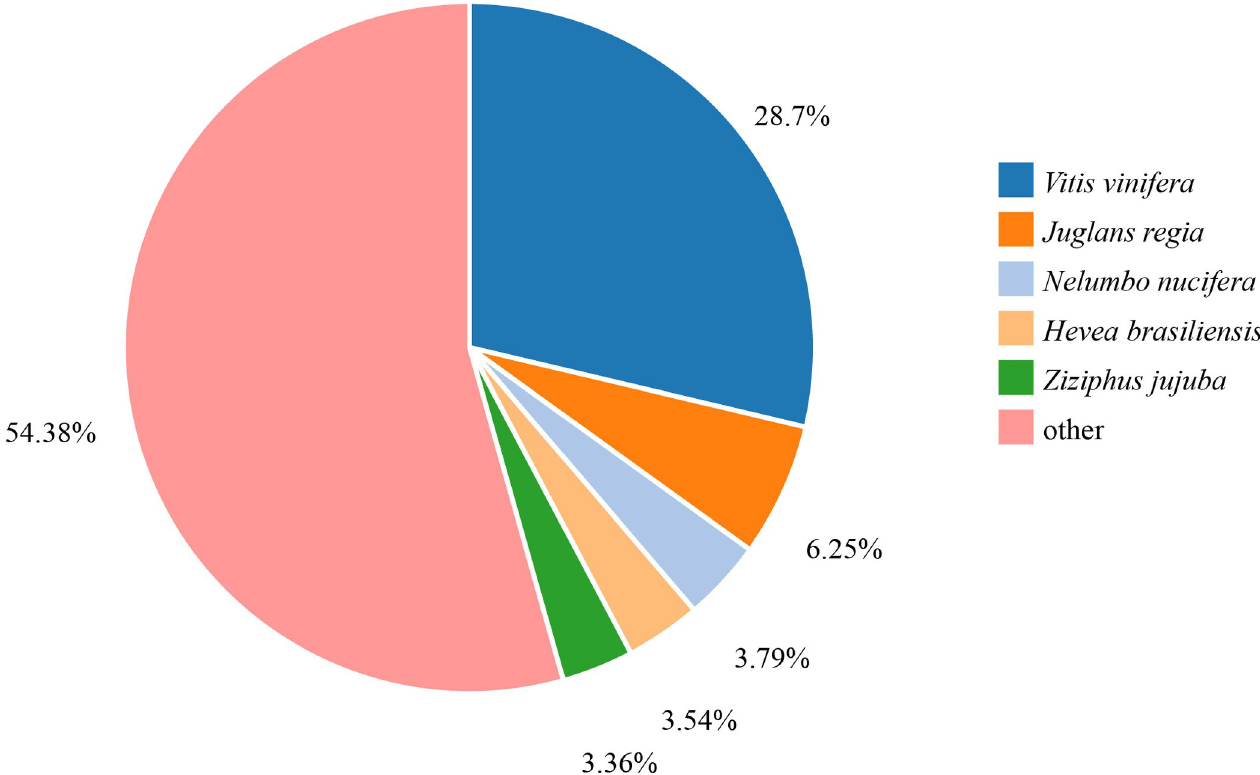
Fig 3. NR species distribution for the annotation with the NR